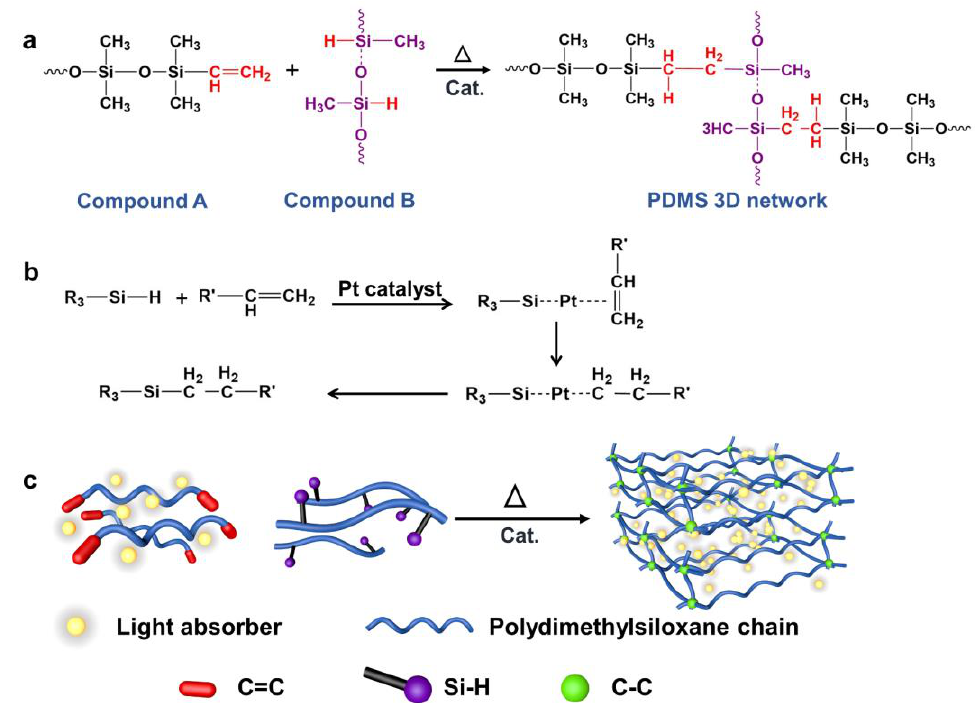
Figure 2. Reaction scheme elucidating the crosslinking chemistry of vinyl-terminated PDMS and the light absorbing PDMS composites. ( a ) Crosslinker (compound B)’s Si -H groups react with the vinyl groups of the prepolymer (compound A) to form a three-dimensional network. ( b ) General mechanism of platinum-catalyzed hydrosilylation for PDMS crosslinking. ( c ) Proposed synthetic procedures of the optically functional PDMS composite, with the nano fillers embedded in the prepolymer as the initial step. The vinyl terminal is labeled as the red cylinder.